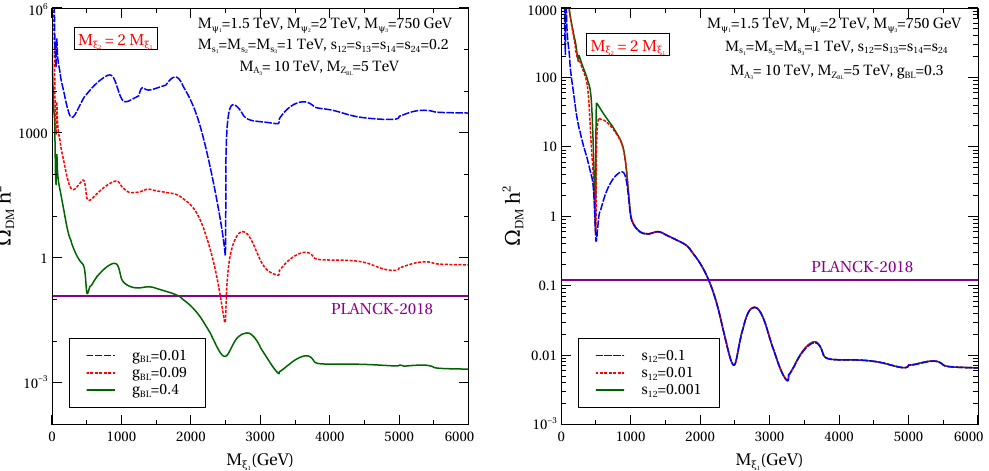
Figure 6 . Relic abundance of two DM candidates with non-degenerate masses ( M (cid:24) for di(cid:11)erent benchmark values of: gauge coupling g BL (left panel), singlet scalar-SM Higgs mixing (right